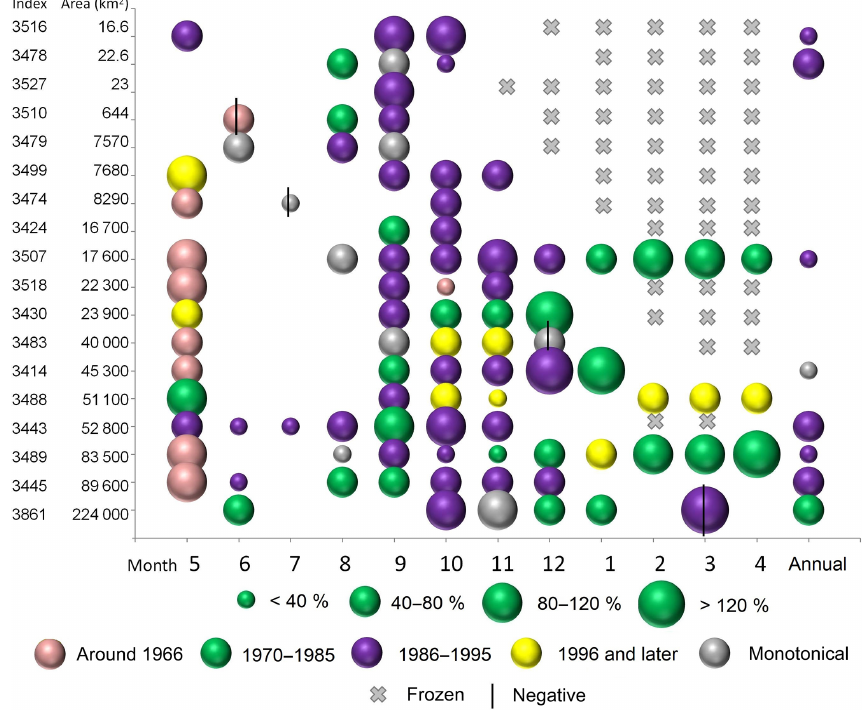
Figure 3. Change in monthly streamflow represented as a percent, along with the period in which that change occurred. Data are for both Yana and Indigirka River basins and are sorted in order of basin area.